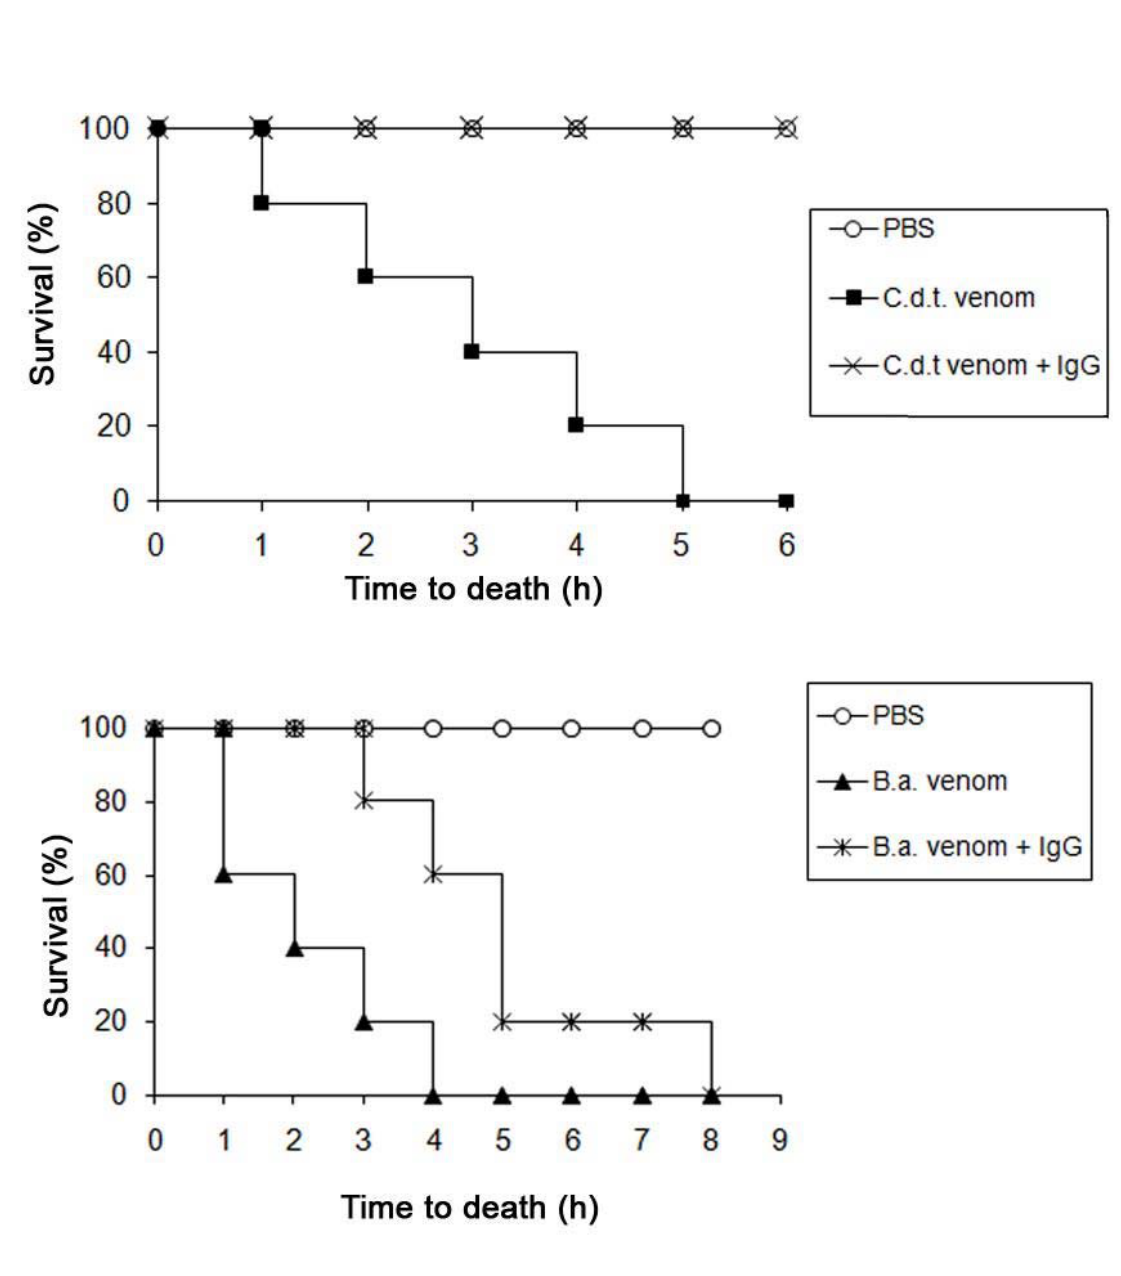
Figure 6. Survival of mice treated with C.d.t. venom , B.a. venom or these venoms pre-incubated with IgG anti- C .PLA. Note that animals inoculated with B.a. venom pre-incubated with IgG anti- C .PLA resisted at least for three hours compared with 2 animals inoculated with venom